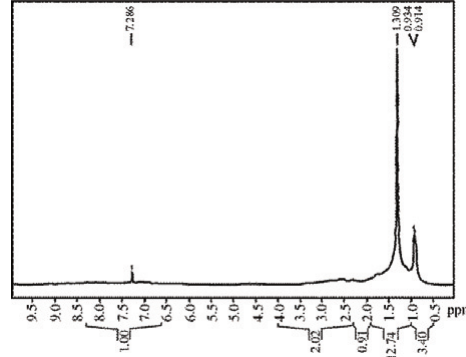
fig. 7. The proton nuclear magnetic resonance spectrum of bitumen